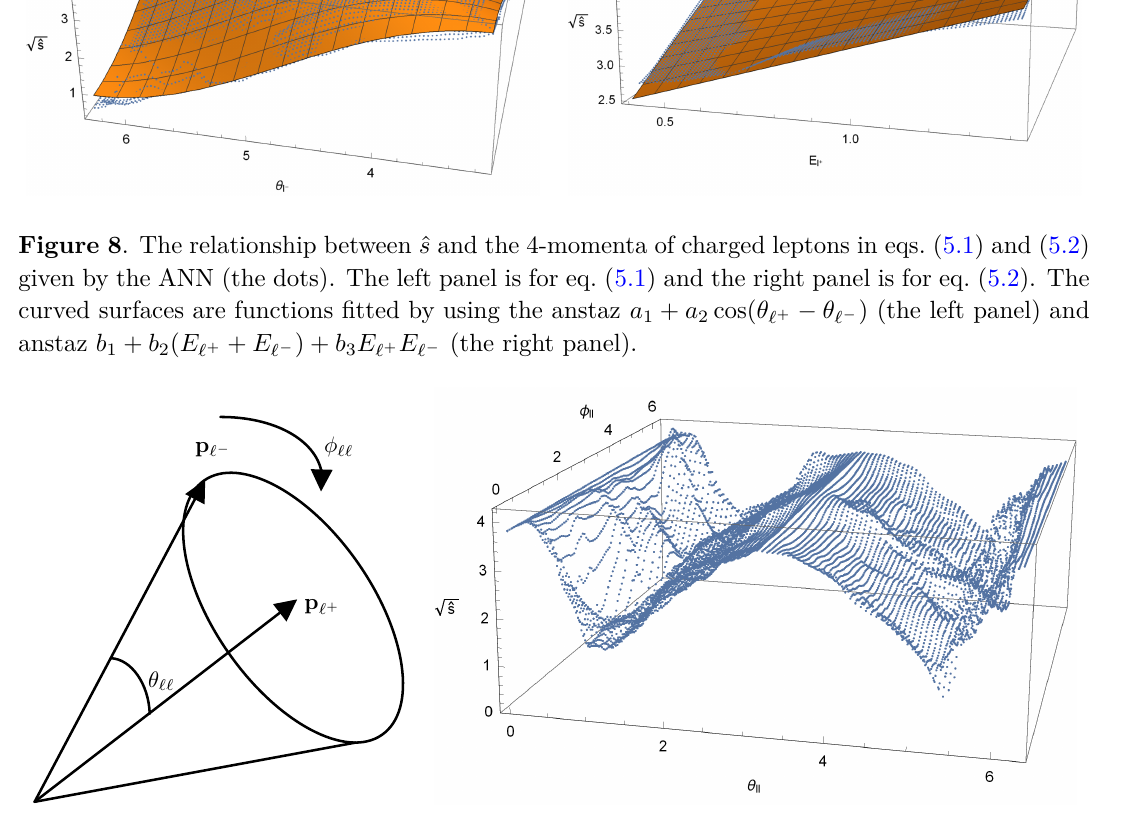
Figure 9 . The directions of the momenta of charged leptons used to study the relationship between ˆ s and the angles between charged leptons are shown in the left panel. The ˆ s as a function of θ ‘‘ and φ ‘‘ given by the ANN is shown in the right